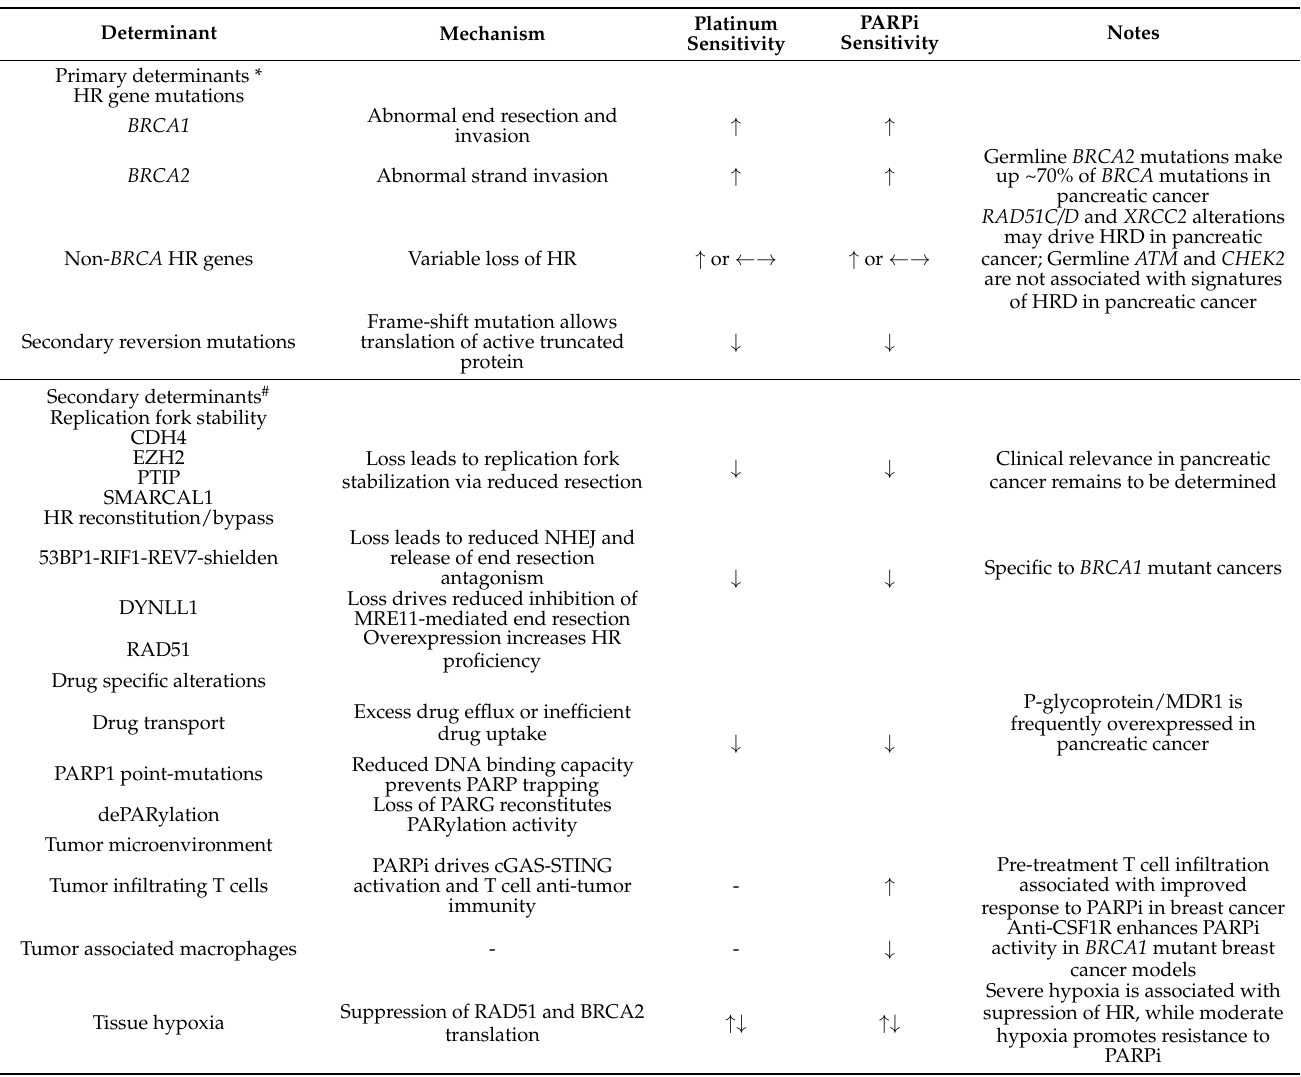
Table 1. Determinants of clinically relevant homologous recombination